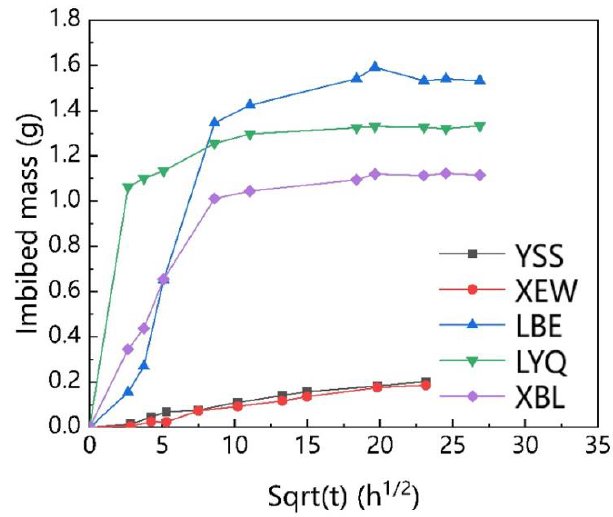
Figure 3. The development of imbibition mass with time.